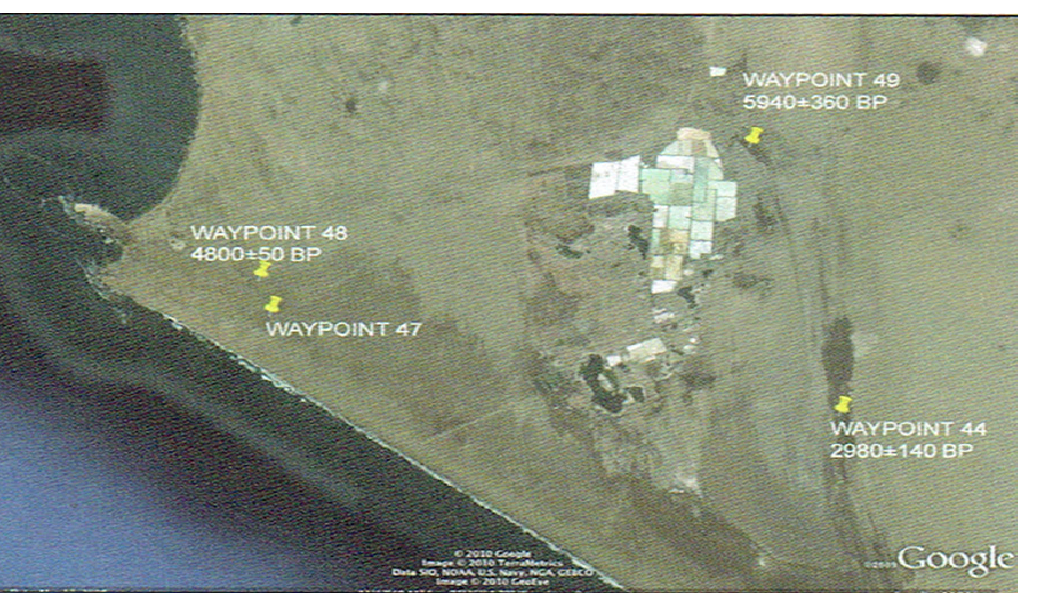
Figure 8. Shoreline changes over time in the area south of the Supe Valley. The dates measured from marine mollusk analysis indicate the variability of the shoreline shape due to ENSO sediment deposition/scouring events over time. (Figure courtesy of Daniel Sandweiss, personal communication). The geophysical landscape changes affecting the agricultural and marine resource base of Late Archaic societies played a catalytic role in the fate of many Late Archaic Pe- riod sites. While research continues into the social, political and economic structure of Late Archaic Period sites and their response to climate change environmental stress to